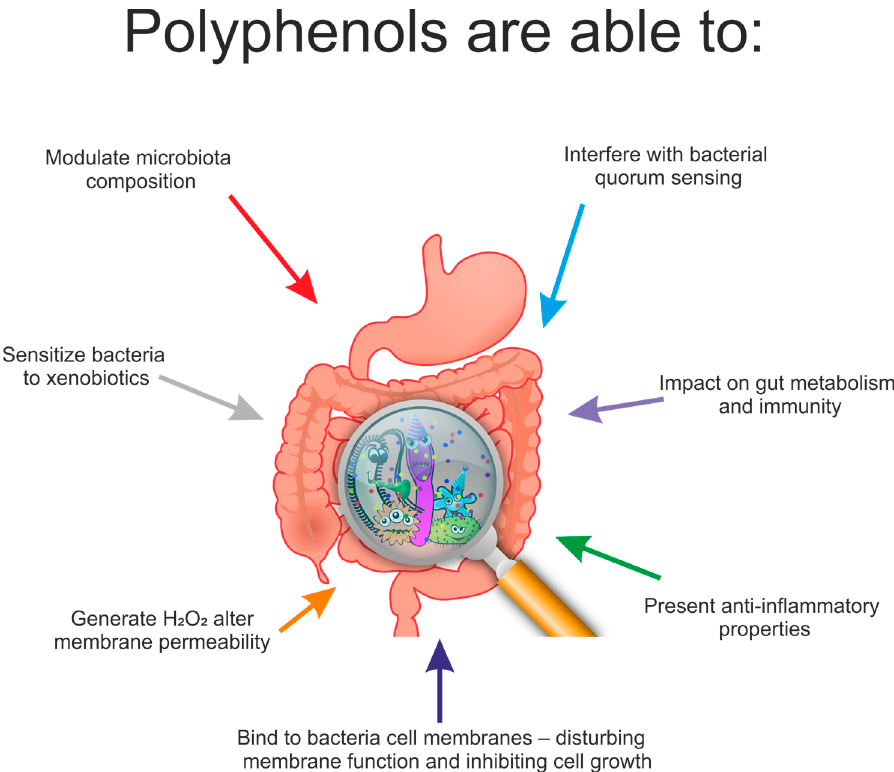
Figure 2. Effect of polyphenols on gut microbiota.